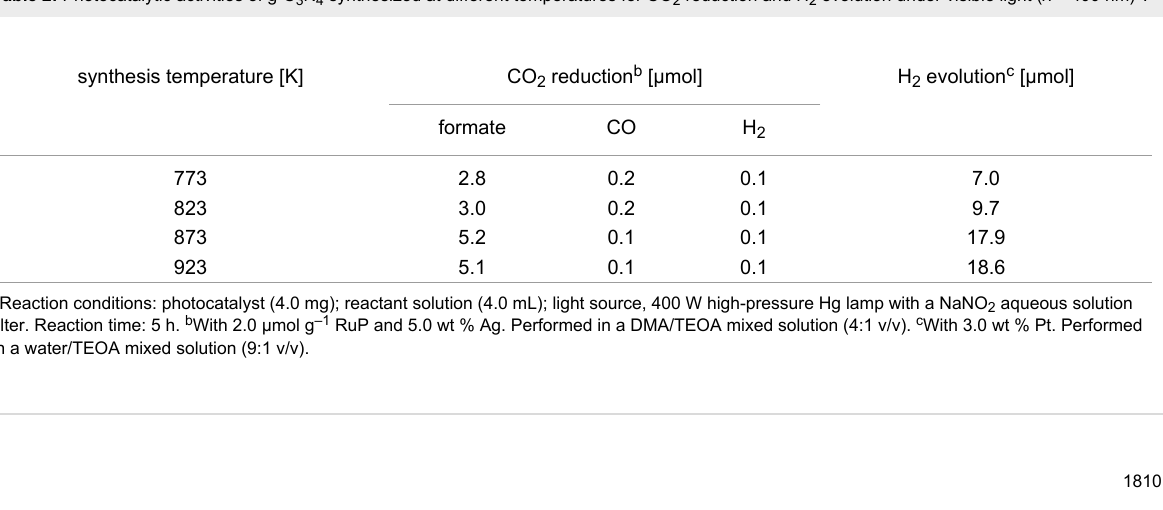
Table 2: Photocatalytic activities of g-C 3 N 4 synthesized at different temperatures for CO 2 reduction and H 2 evolution under visible light ( λ > 400 nm) a .